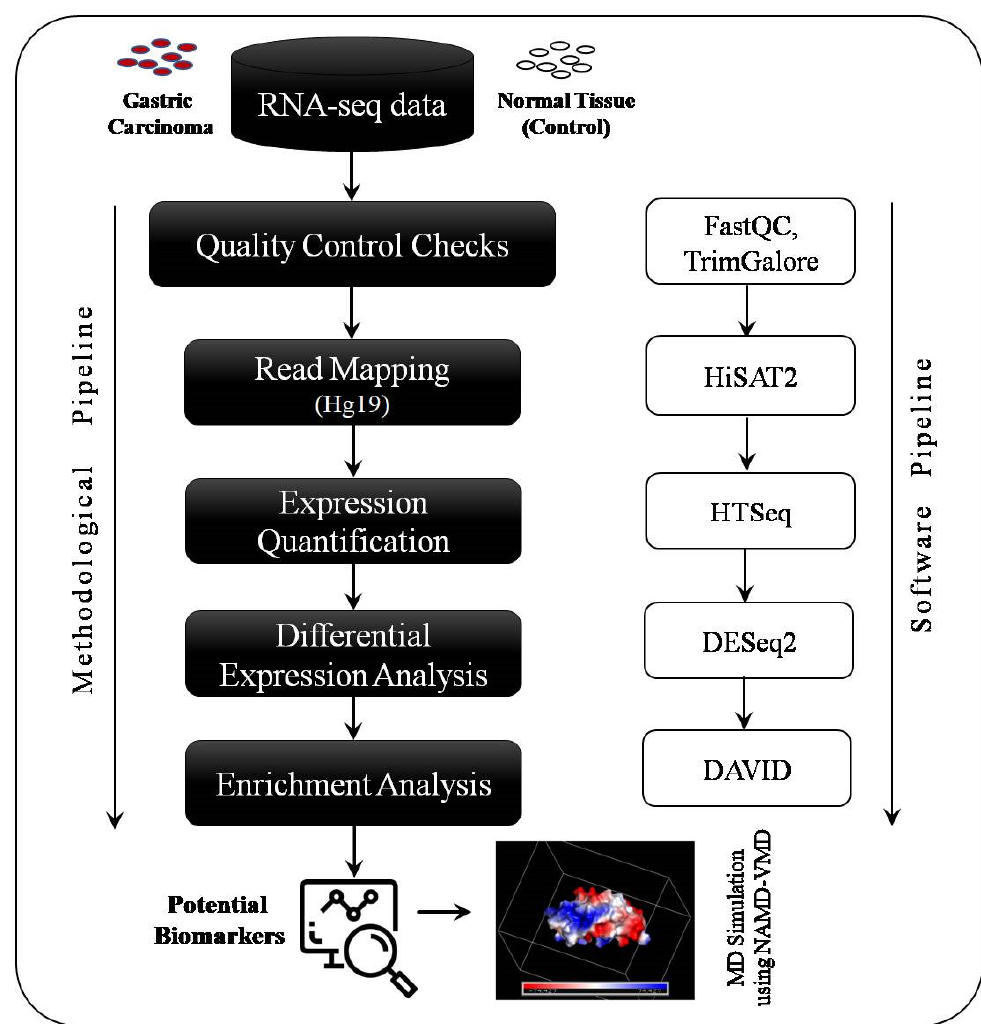
Figure 1. RNA-seq analysis methodological and software pipeline.